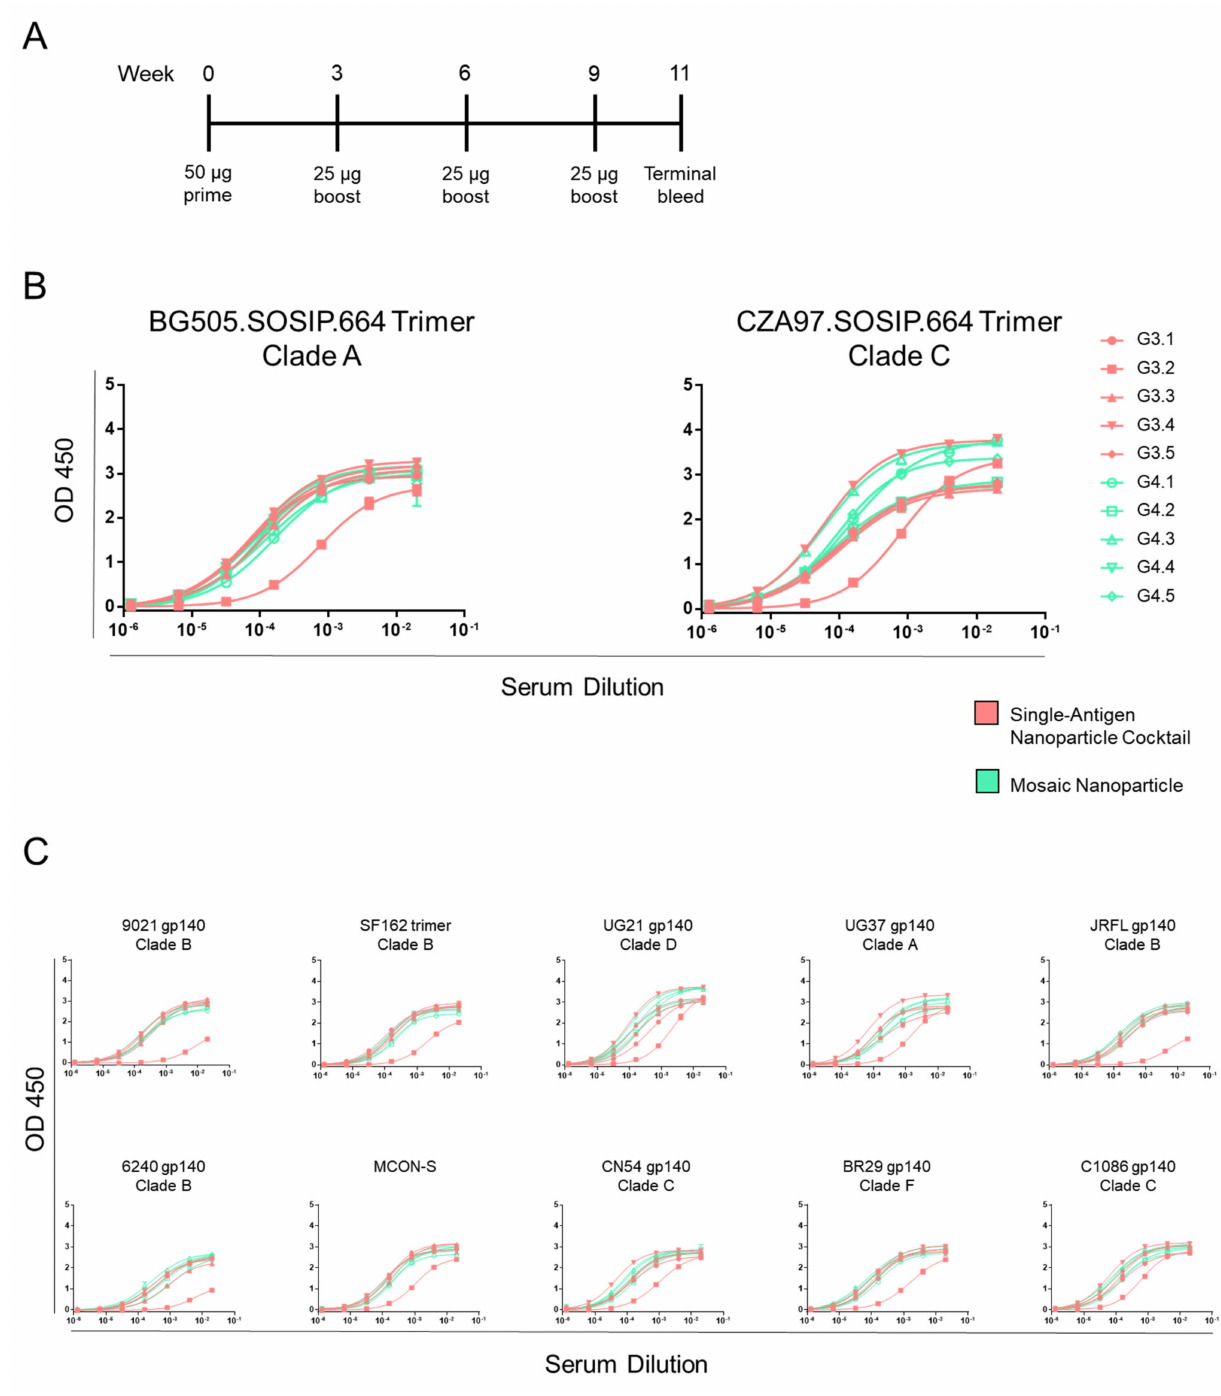
Figure 4. Guinea pigs immunized with nanoparticles show the breadth of reactivity against diverse HIV-1 envelope proteins (Envs). ( A ). Guinea pig immunization scheme. Guinea pigs were primed at day zero and boosted every three weeks. Terminal bleeds were performed two weeks after the final boost. ( B ). ELISA binding curves against vaccine—matched Envs. Guinea pigs ( n = 5) were immunized with either the single—antigen nanoparticle cocktail (G3.1–3.5) or mosaic nanoparticles (G4.1–4.5). Each guinea pig is color-coded by the immunization group. Curves refer to binding to BG505 ( left ) or CZA97 ( right ) trimer. ( C ). ELISA binding curves to gp140 Env proteins from diverse